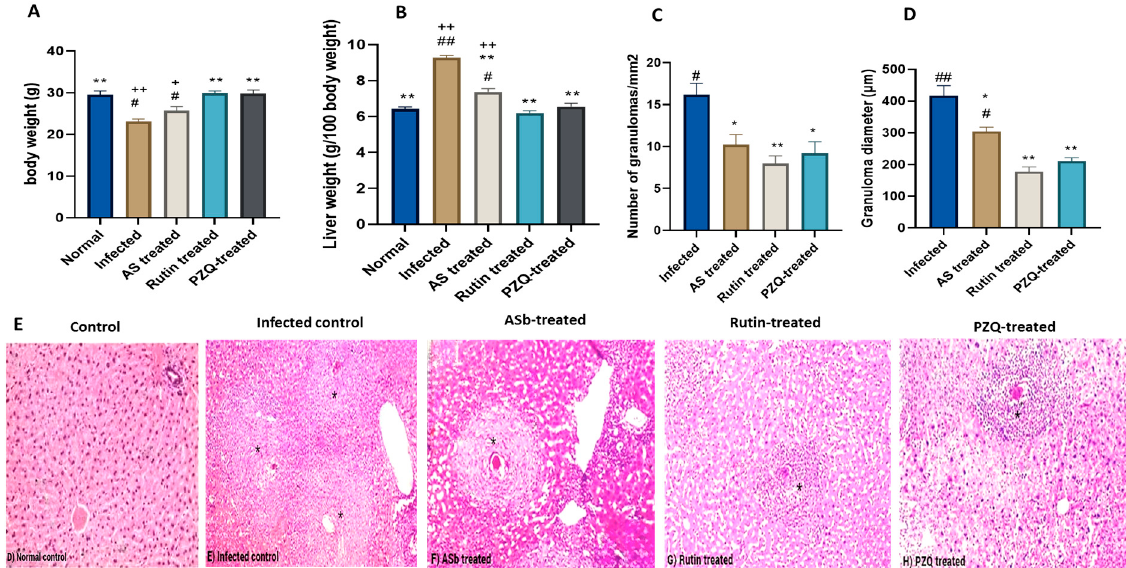
Figure 2. Effect of treatment with rutin naturally isolated from A. sativum on the pathological damage caused by infection with 100 ± 2 S. mansoni cercariae, 8 weeks postinfection. Effect of different treatments on ( A ) body weight, ( B ) liver weight (relative to body weight), ( C ) number of granulomas, ( D ) average granuloma diameter in the liver tissues of S. mansoni -infected CD1 mice, ( E ) histological liver sections stained with H&E (Scale bars: 100 µ m). Black star shows the granuloma area. Data expressed as mean ± SE ( n = 5). p -value represented the relationship between AS b- and rutin-treated groups and normal control, and S. mansoni -infected controls and drug controls. * p < 0.05, ** p -value < 0.001, compared with infected control group; + p < 0.05, ++ p -value < 0.001 in comparison to normal control group; # p < 0.05, ## p -value < 0.001 in comparison to PZQ control group. The severity of fibrosis was also assessed using the fibrosis scoring system, which revealed that rutin, like PZQ, had similar beneficial effects on S. mansoni -induced fibrosis (Table 4). Table 4. Histopathological analysis in mice after different